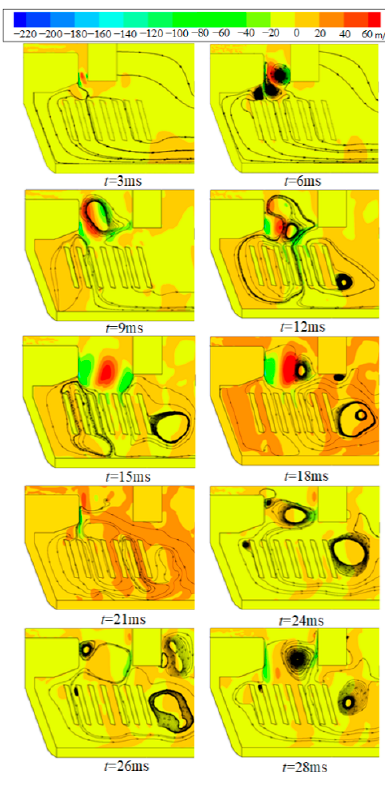
Figure 10. Velocity distribution (DC 1500 V).